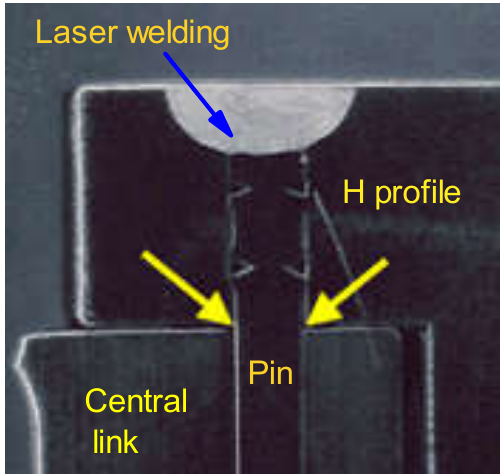
Figure 8. The arrows indicate the area targeted by the electrochemical stress corrosion test. Optical examination, magnification 10×.